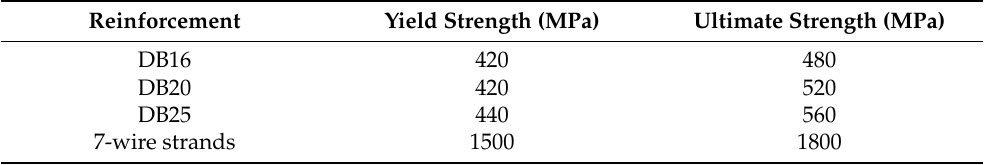
Table 3. Mechanical properties of steel